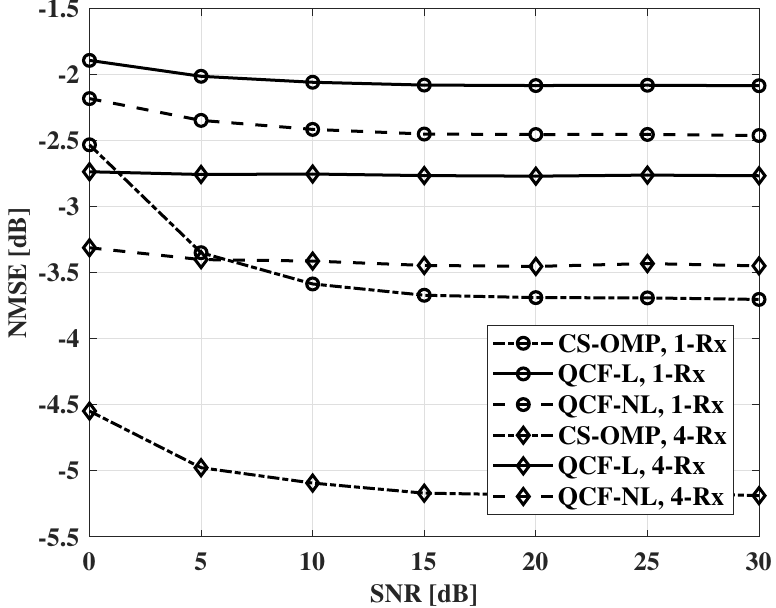
Figure 7. NMSE measurements according to SNR, codebook size = 6 bits, N t = 64, and N r =